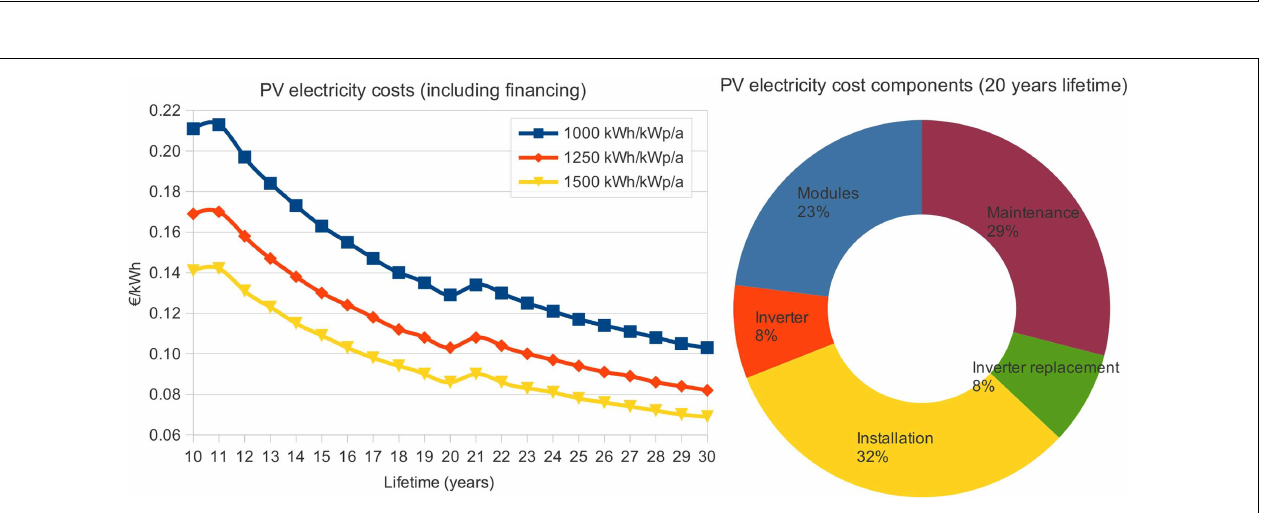
FIGURE 2 | Basic PV costs as function of lifetime and cost composition for three hypothetical sites .